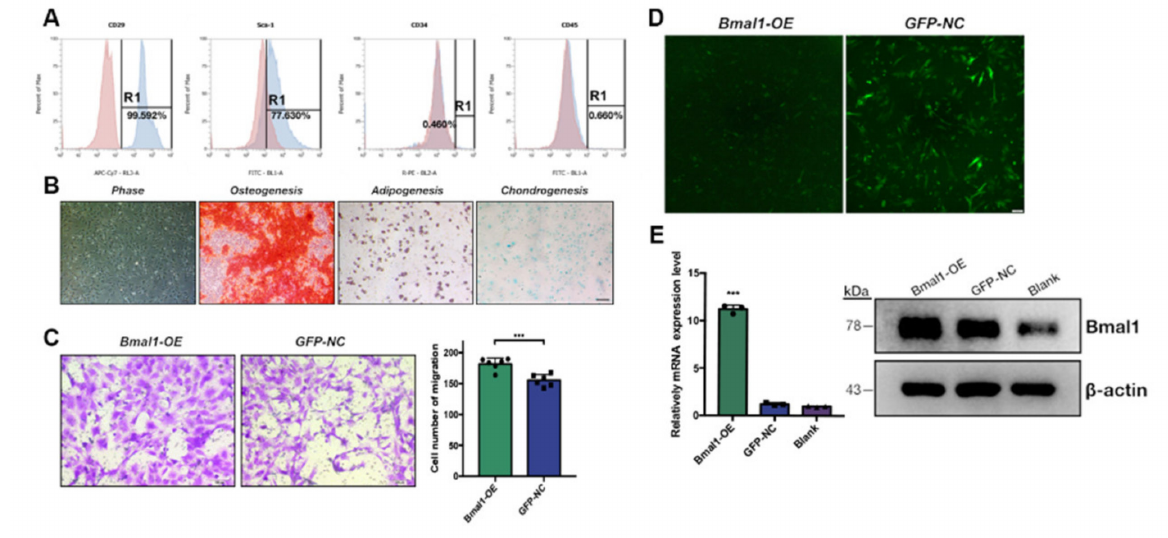
Figure 5. Effect of Bmal1 overexpression in primary BMSCs. ( A ) Identification of primary BMSCs by flow cytometric analysis. Cells were labeled with CD29 and Sca-1 as positive markers; CD34 and CD45 as negative markers. ( B ) Morphology of cultured BMSCs and Alizarin Red, Oil Red, and Alcain Blue staining of BMSCs under conditional culture medium. ( C ) Fluorescence microscopy of Bmal1 -OE and GFP-NC BMSCs after lentivirus transfection. Scale bar: 200 µ m. ( D ) qRT-PCR and Western blot analysis of Bmal1 expression of Bmal1 -OE and GFP-NC BMSCs. *** p < 0.001. ( E ) Cell migration of Bmal1 -OE and GFP-NC BMSCs was determined by transwell assay. *** p <